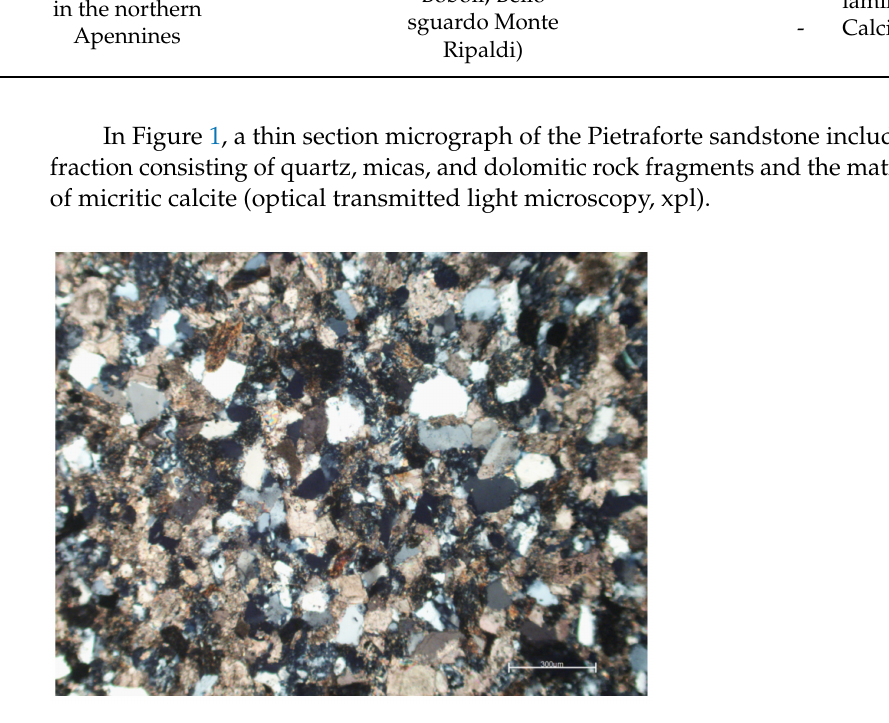
Figure 1. Thin section of a sample of Pietraforte, collected in the bell tower of San Lorenzo